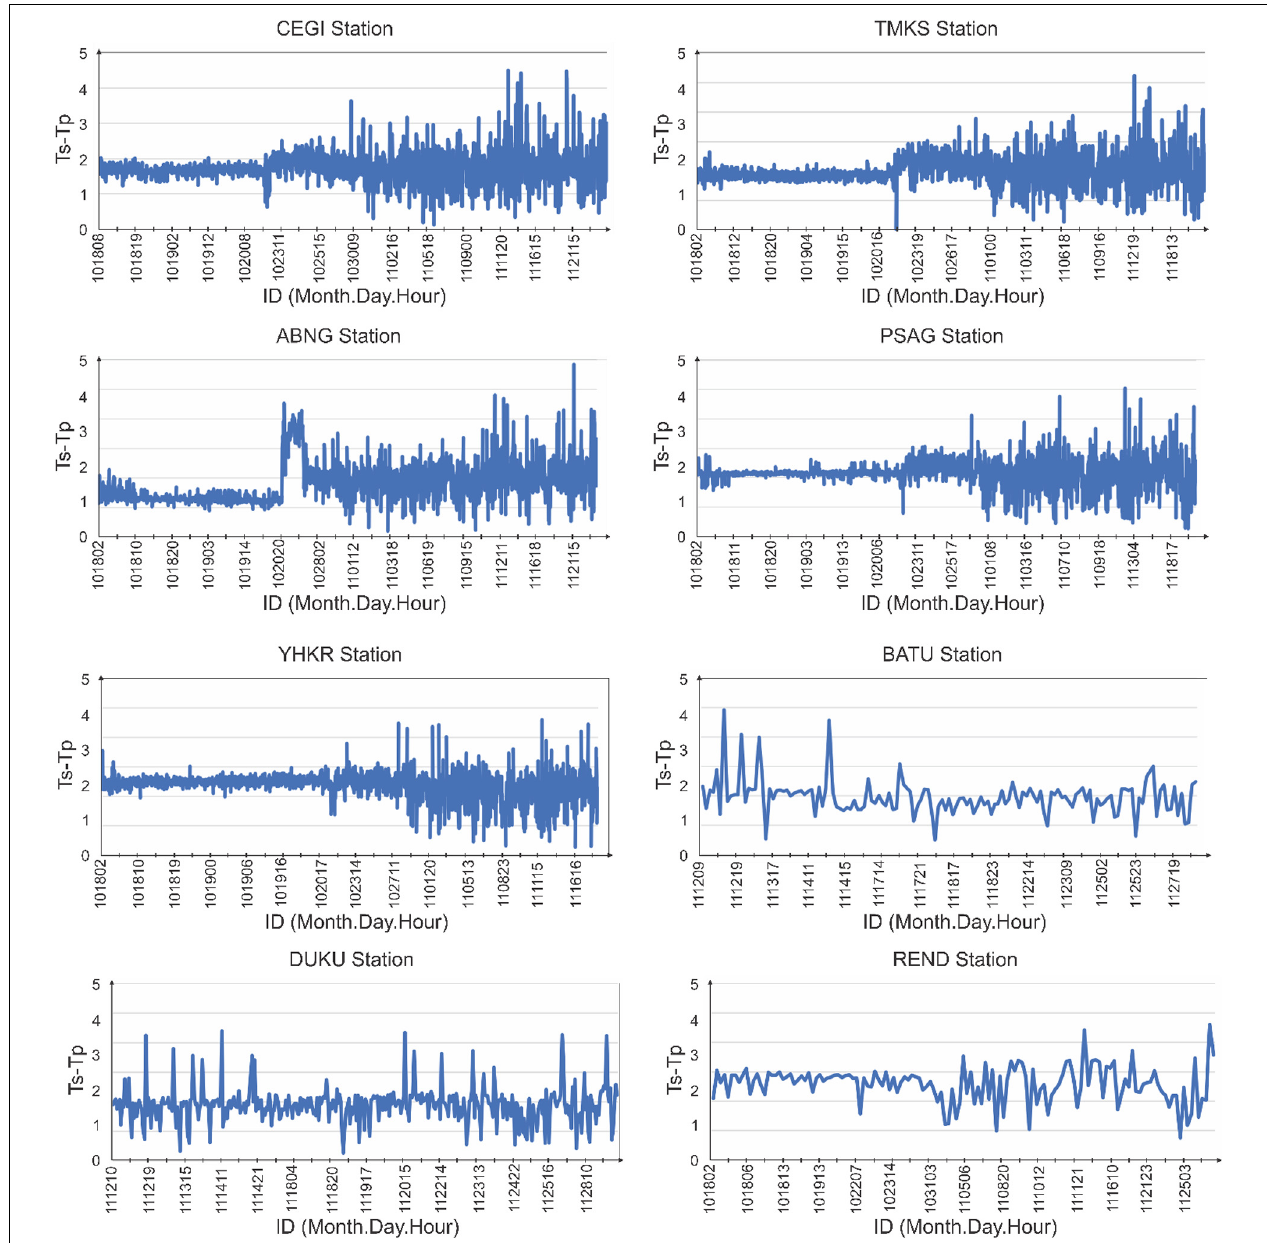
FIGURE 5 | Arrival time delay between primary (Tp) and secondary waves (Ts) at each seismographic station surrounding Agung volcano. The x axis is the ID of detected events at each station. The ID consists of six digits character representing month, day, and hour of each event’s origin